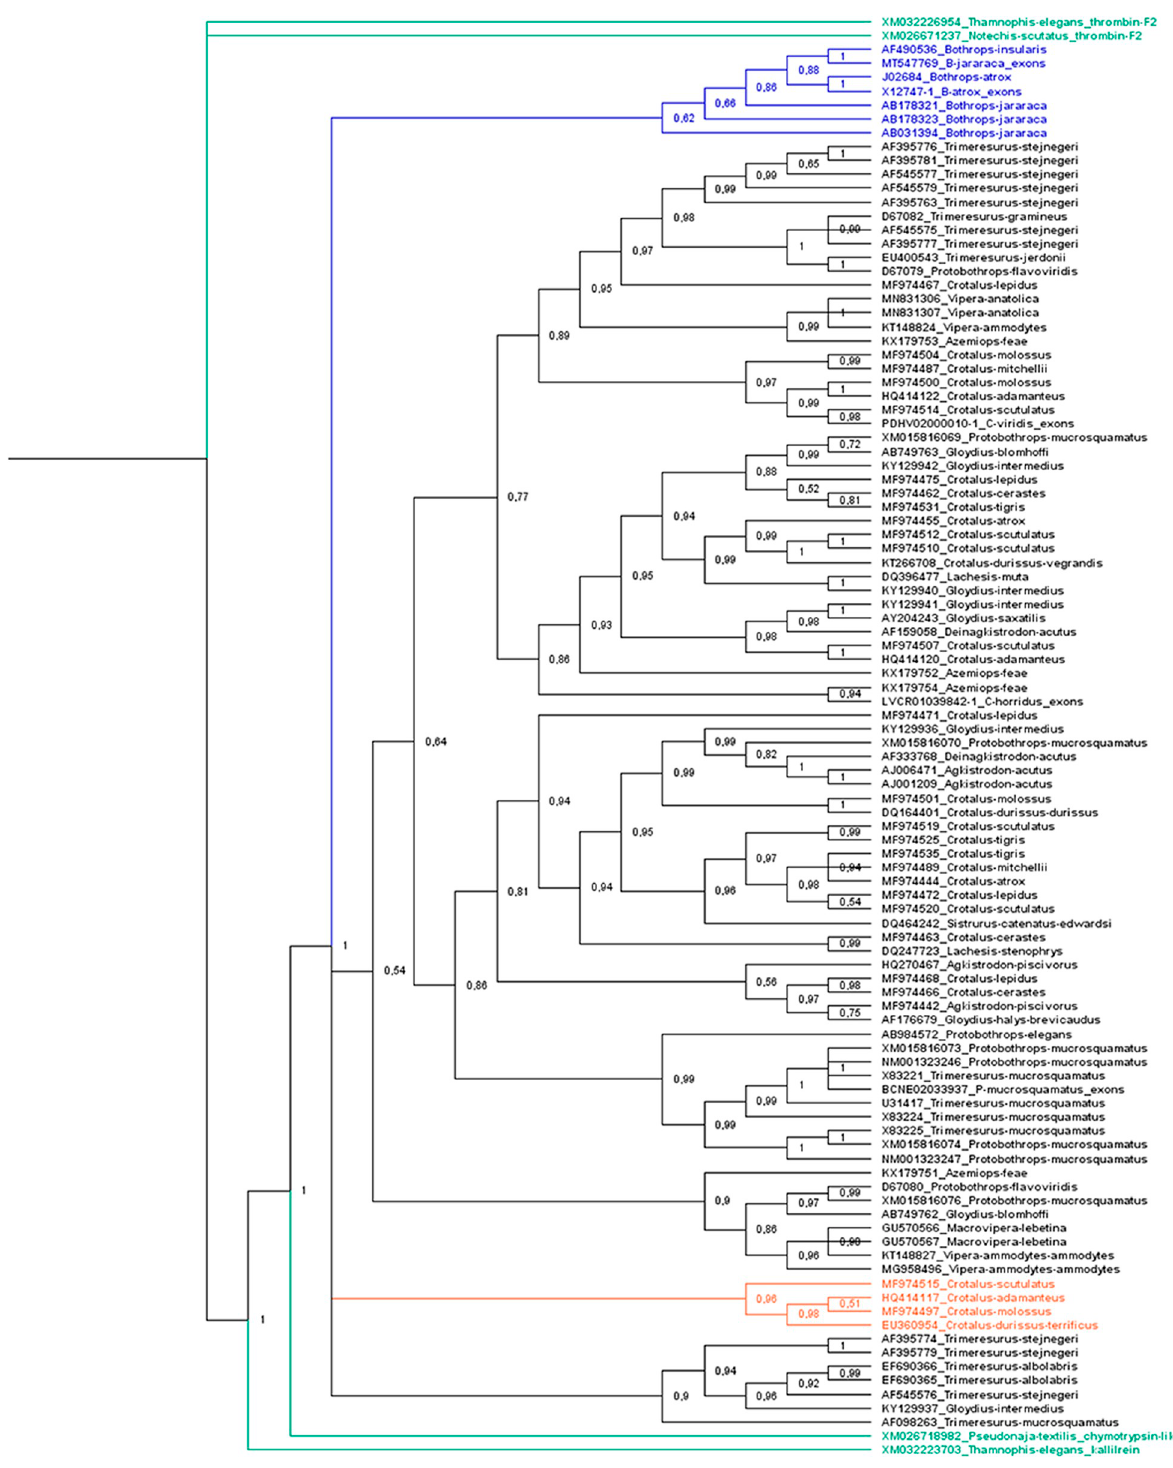
Fig 3. Cladogram of SVTLE coding sequences. The tree was constructed with Mr. Bayes 3.2.6 using Thamnophis elegans thrombin (XM032226954) as the outgroup and GTR as the nucleotide substitution model. In green, thrombin, chymotrypsin, and kallikrein codifying sequences; in blue, the batroxobin-like sequences; and orange, the gyroxin-like sequence.